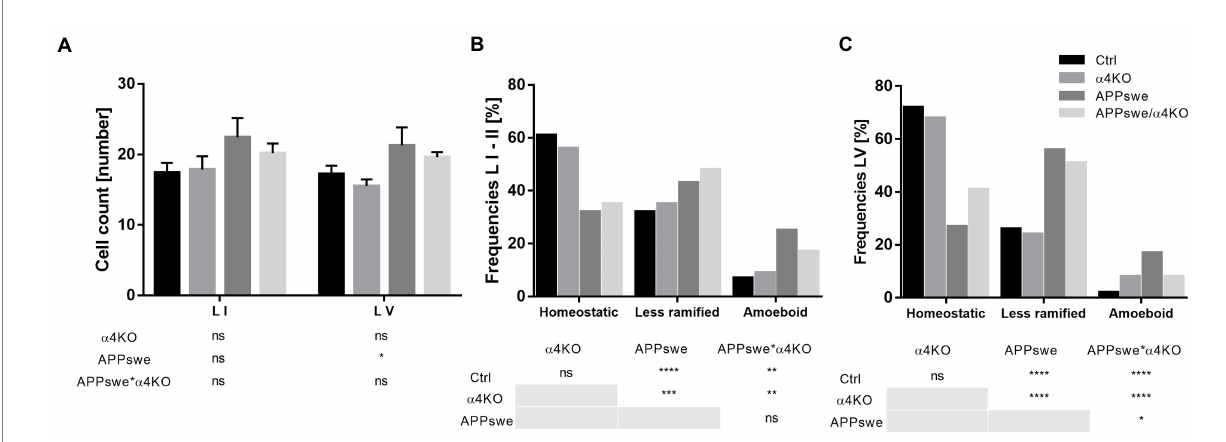
FIGURE 8 Classification of morphological phenotypes of microglial cells in 15 mo mice. Quantitative analysis of microglial density in layers I–II and layer V (A) of sCtx and relative frequency in homeostatic, less ramified, or amoeboid state (B,C) . In A , data are shown as mean ± SEM and compared by two-way ANOVA test; in B,C , frequencies are shown as % by each group and analyzed by Chi-square test. * p < 0.05, ** p < 0.01, *** p < 0.001, **** p < 0.0001. L I–II, V, layers I–II,